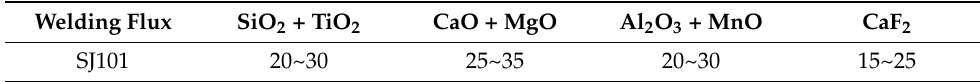
Table 4. Flux chemical composition of SJ101 (wt.%).